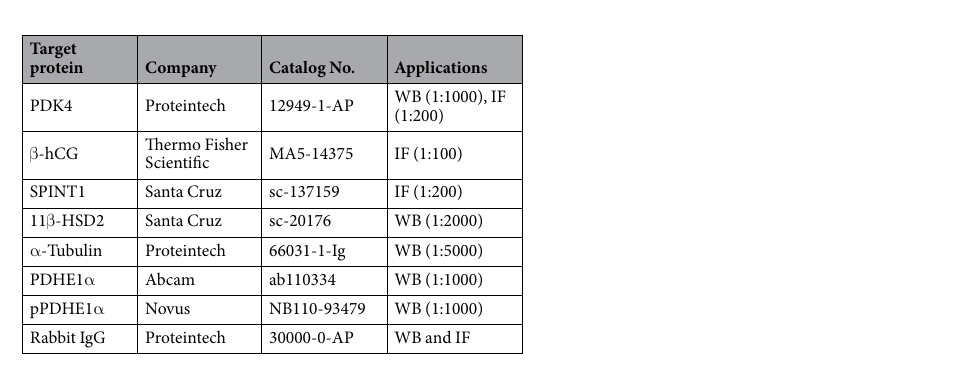
Table 1. Information of the antibodies for immunohistochemical staining and western